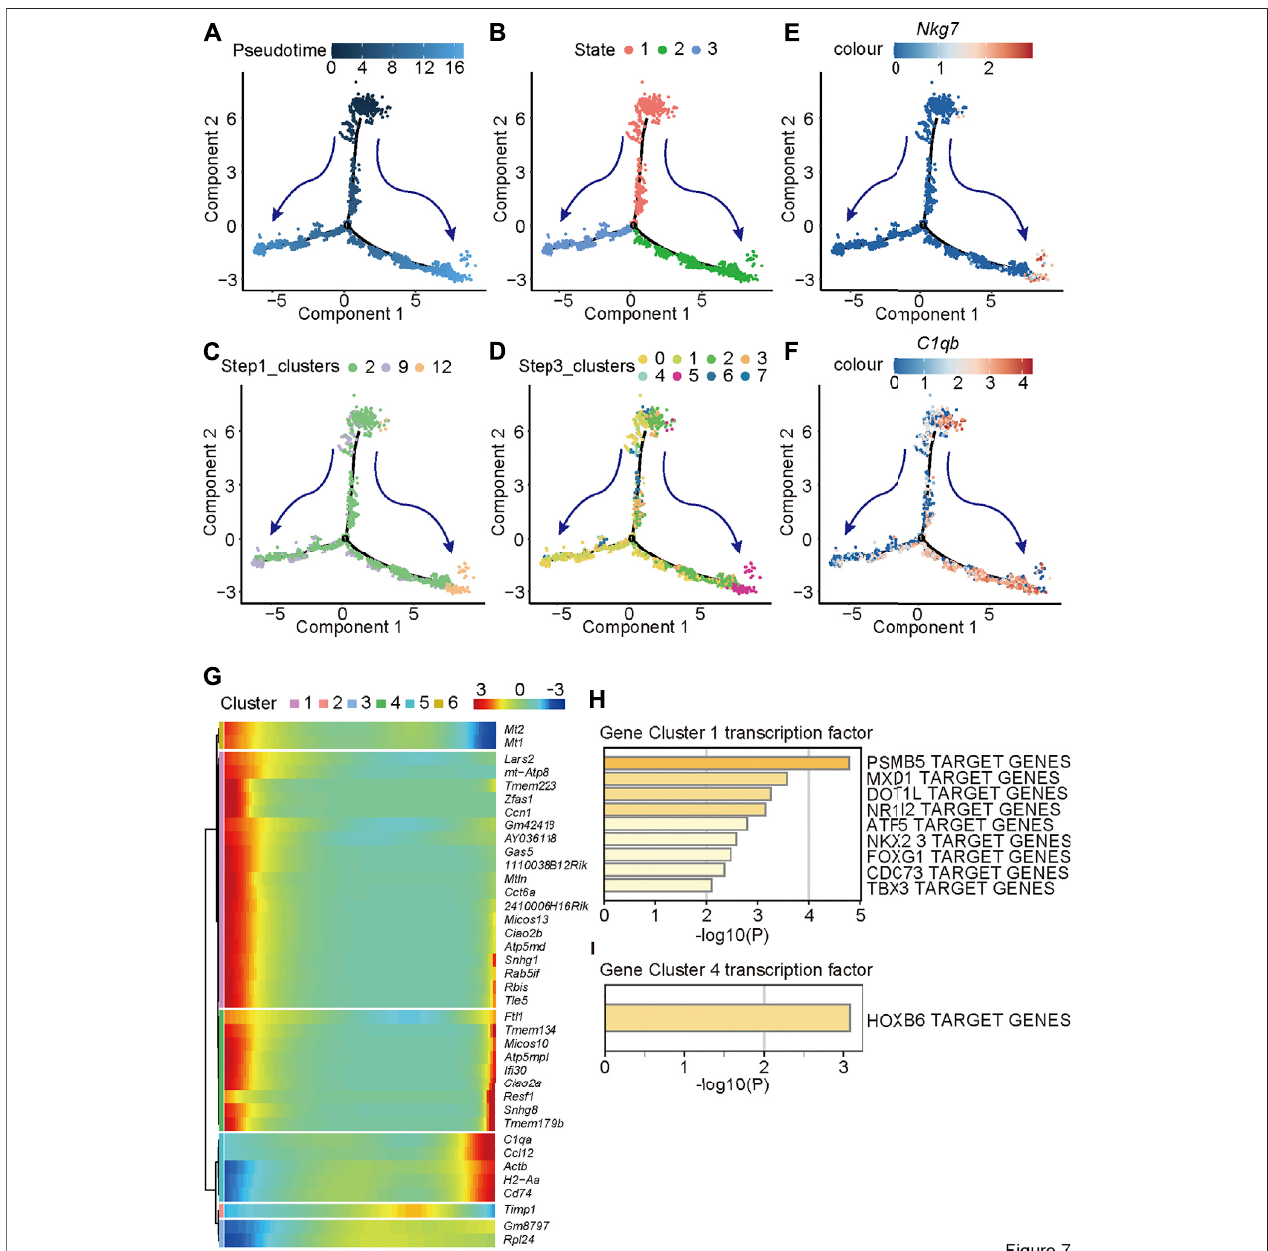
FIGURE 7 | Pseudotime analysis reveals the trajectory of delineation from tumor-associated monocytes to NK-like non-functioning cells. Pseudotime analysis on theTAMcellsofStep1re-clustering(clusters2,9and12)and (A) Pseudotime; (B) States; (C) labelingbyStep1re-clusteringclusters (D) labelingbyStep2re-clustering clusters; (E,F) monocytes and NK cell marker gene expression level ( C1qb and Nkg7 ). (G) The trend of the gene expression generated by the BEAM function along pseudotimeofStep1re-clustering(clusters2,9and12)TAMpopulation. (H) Metascapebiologicalprocessesenrichmentanalysisbyusing geneclustersabtained from BEAM